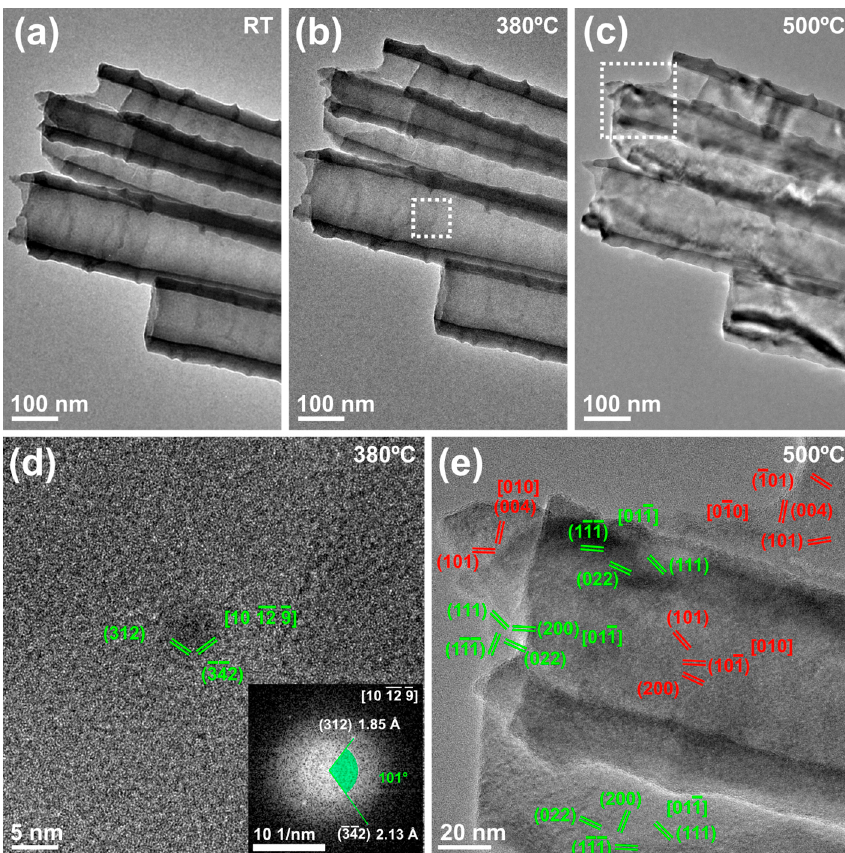
Figure 5. In situ HRTEM heating experiment of bigger TANs: ( a – c ) Evolution of the aggregates of TANs recorded at RT ( c ), 380 °C ( b ) and 500 °C ( c ), The white dotted rectangles indicate the regions of interest analyzed by HRTEM and reported in panels d and e ; ( d ) HRTEM image of a brookite seed (in green) recorded at 380 °C (see the rectangle in panel 3 b ). The inset presents the corresponding 2D-FFT, showing the interplanar distances and angular relationships expected for the brookite; ( d ) HRTEM image of extended crystal domains of brookite (in green) and anatase (in red) recorded at 500 °C (see the rectangle in panel 4 c ).